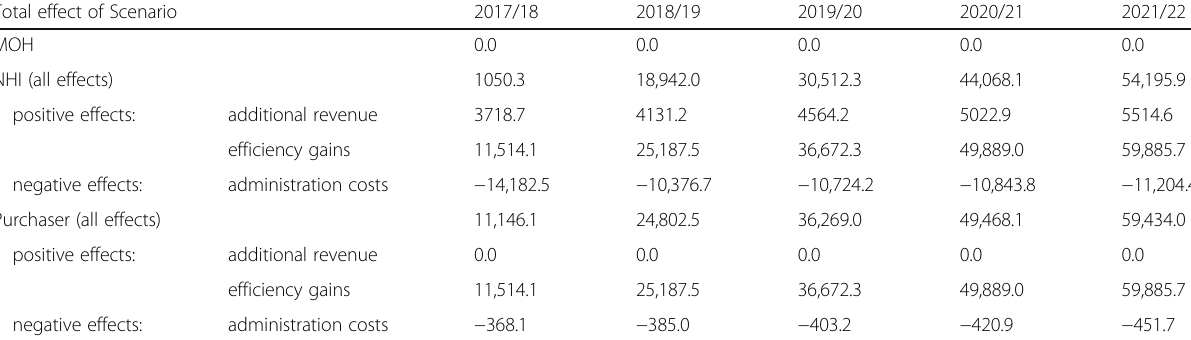
Table 3 Comparison of financial effects of the reform scenarios (MWK million)